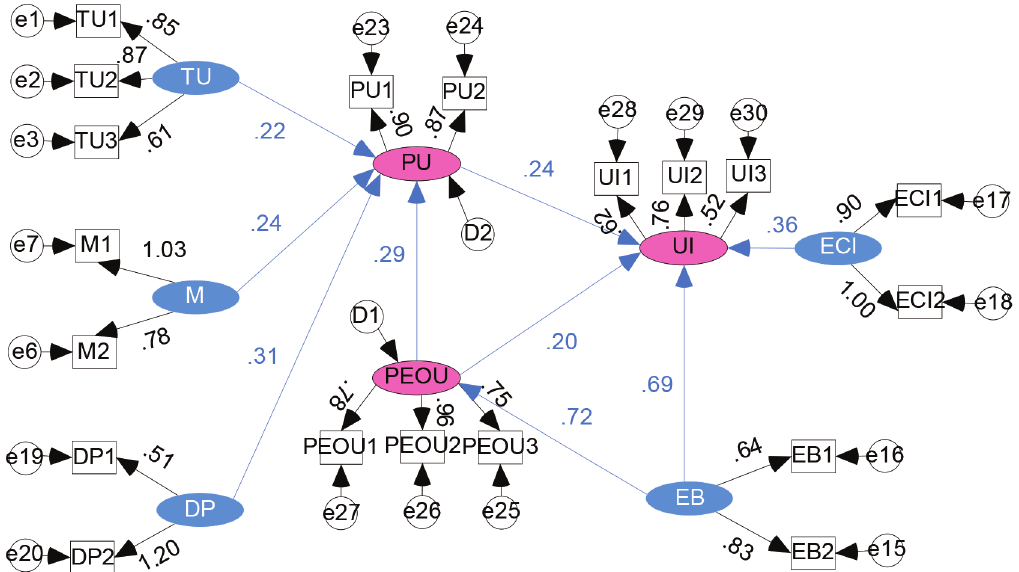
Figure 5. The optimal